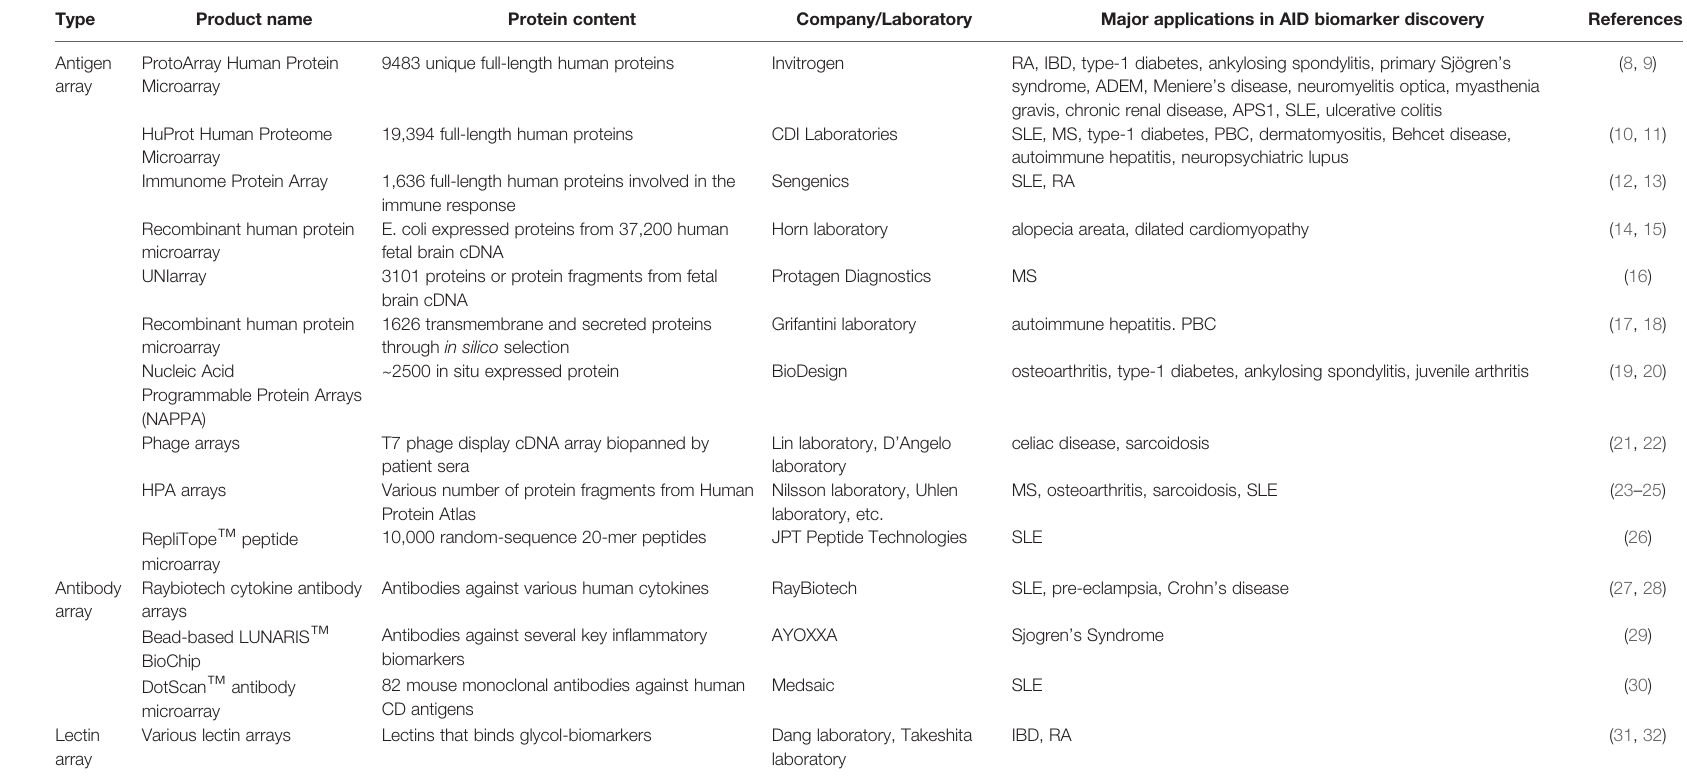
TABLE 1 | Major protein microarray platforms for biomarker discovery in autoimmune